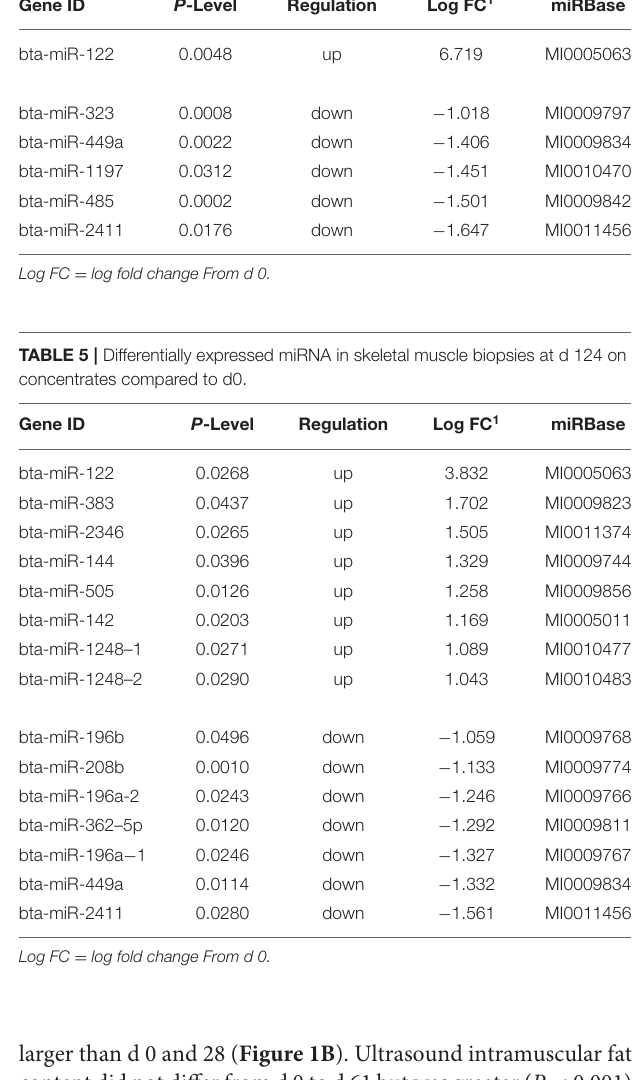
TABLE 4 | Differentially expressed miRNA in skeletal muscle biopsies at d92 on concentrates compared to d0. Gene ID